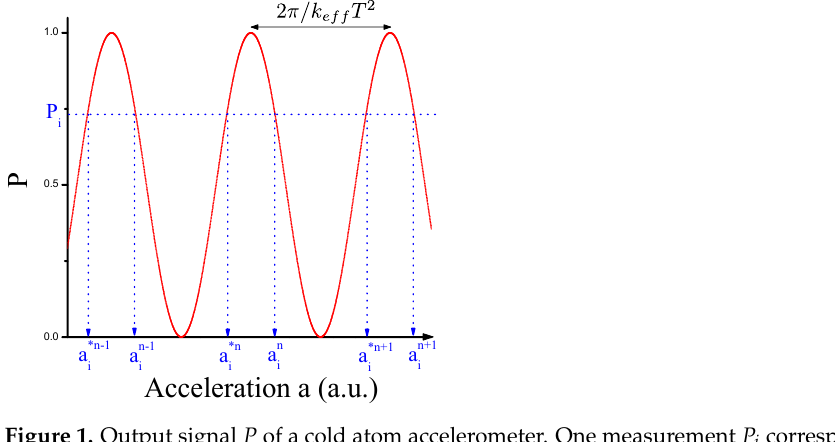
Figure 1. Output signal P of a cold atom accelerometer. One measurement P i corresponds to several possible acceleration values a n , a ∗ n . This ambiguity can be resolved thanks to hybridization with a i i classical accelerometer. Here, P 0 = 0.5 and C =